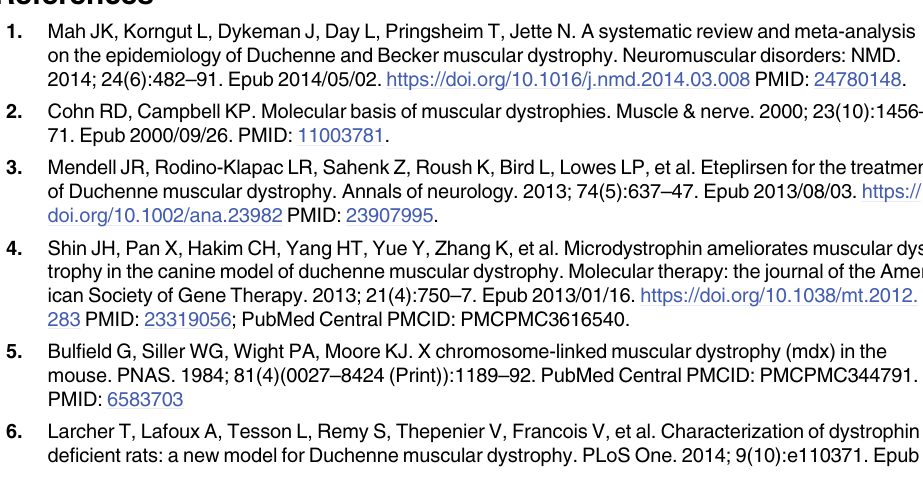
S6 Table. Normfinder ‘best pair’ combinations for all dataset/grouping combinations. S7 Table. Correlation matrix of Cq values. Pearson correlations (r) for raw Cq values (all genes). Bold: correlations between high scoring candidates (ACTB, RPL13a, CSNK2A2, AP3D1). Italics: correlations with P values greater than 0.0001 (all other correlations